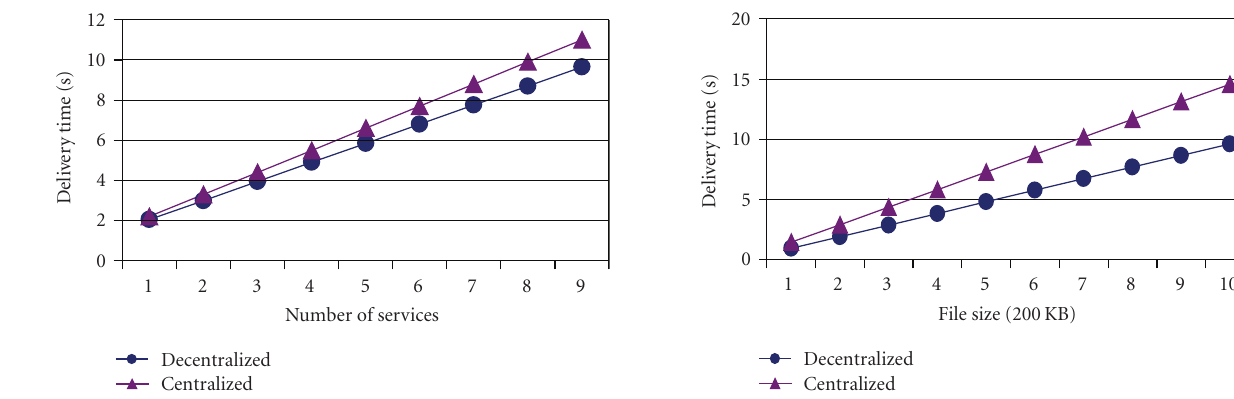
Figure 8: Data delivery time versus number of services. (Bandwidth = 54 Mbps, file size = 1Mbyte.)